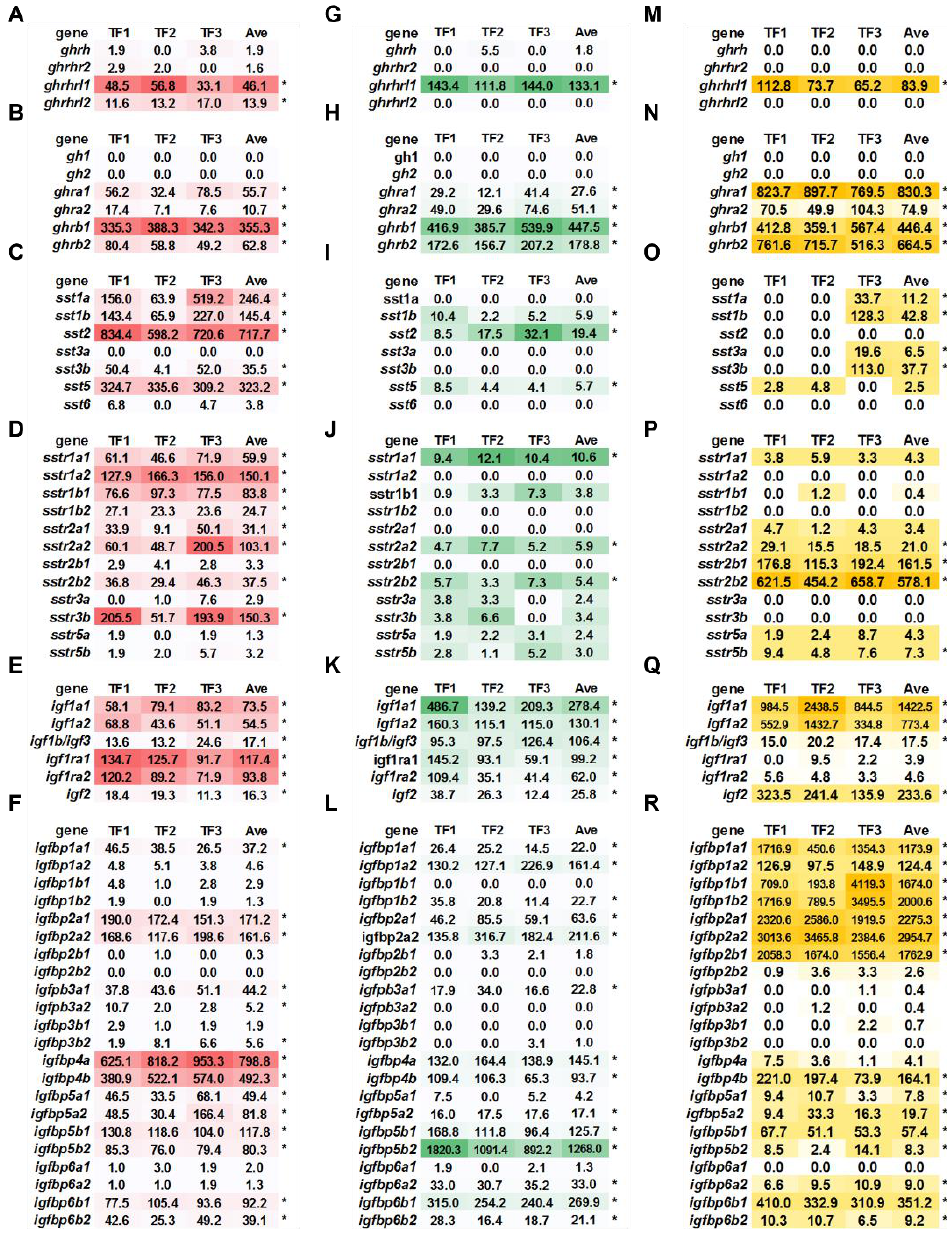
Figure 2. The basal expression of ghrh-sst-gh-igf axis in triploid trout. ( A – F ) The gene expression of ghrh and receptors ( A ), gh and receptors ( B ), sst ( C ), sstr ( D ), igf and receptors ( E ), and igfbps ( F ) in brain. ( G – L ) The gene expression of ghrh and receptors ( G ), gh and receptors ( H ), sst ( I ), sstr ( J ), igf and receptors ( K ), and igfbps ( L ) in kidney. ( M – R ) The gene expression of ghrh and receptors ( M ), gh and receptors ( N ), sst ( O ), sstr ( P ), igf and receptors ( Q ), and igfbps ( R ) in liver. The gene expression levels were generated via counts normalized by DESeq2. The “*” indicates average count > 5.